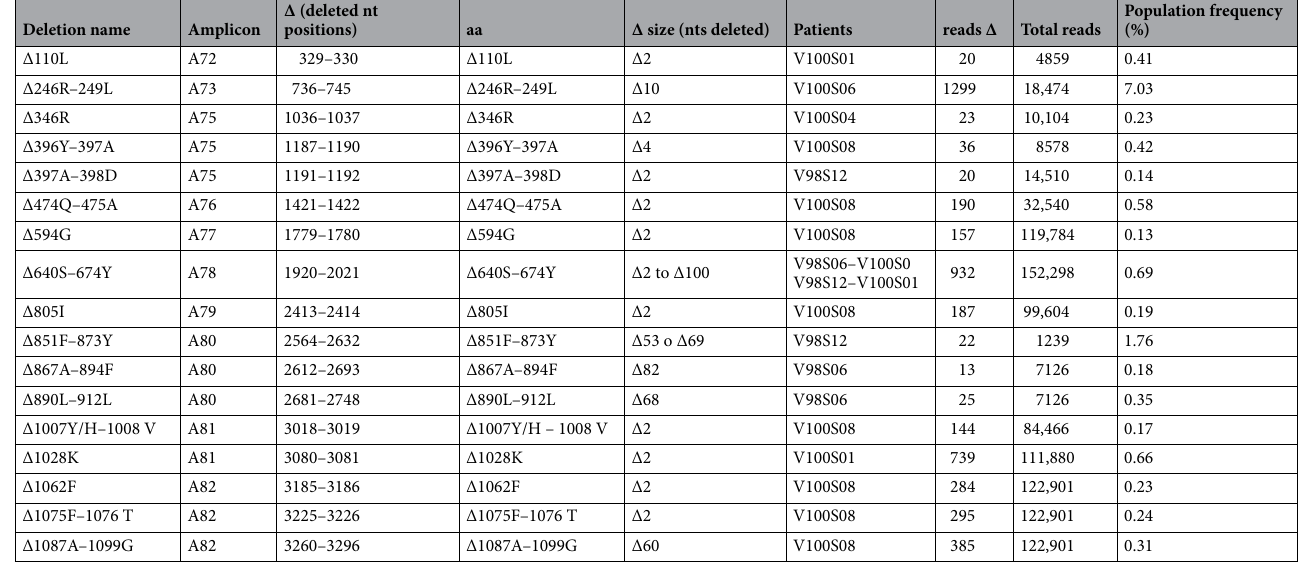
Table 7. Variant B.1.1.529